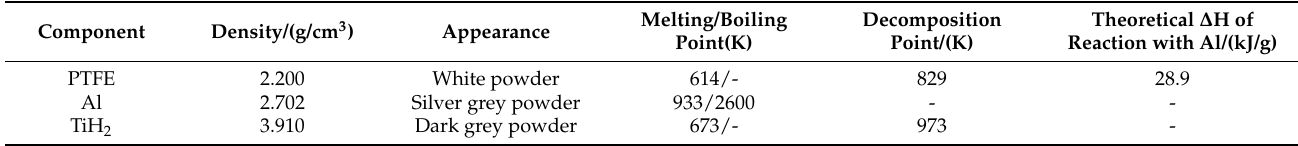
Table 2. The physical and chemical properties of raw materials.